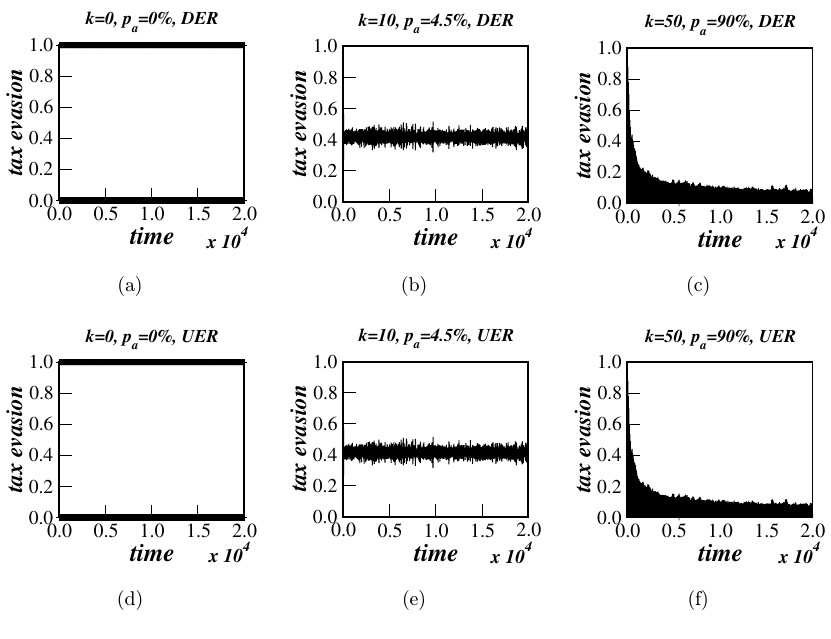
Fig. 3. The same simulation design as in Fig. 2, but now on DER and